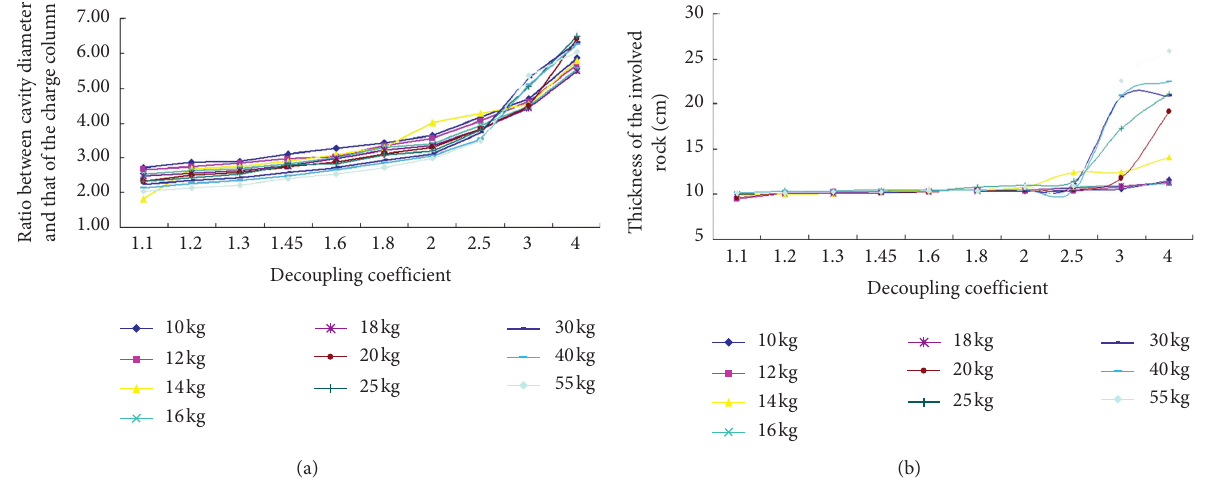
Figure 7: Statistics of the diameter of the